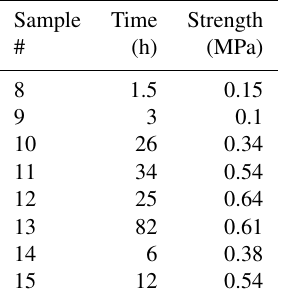
Table 4. Results from testing saline bond experiments at − 3 ◦ C.